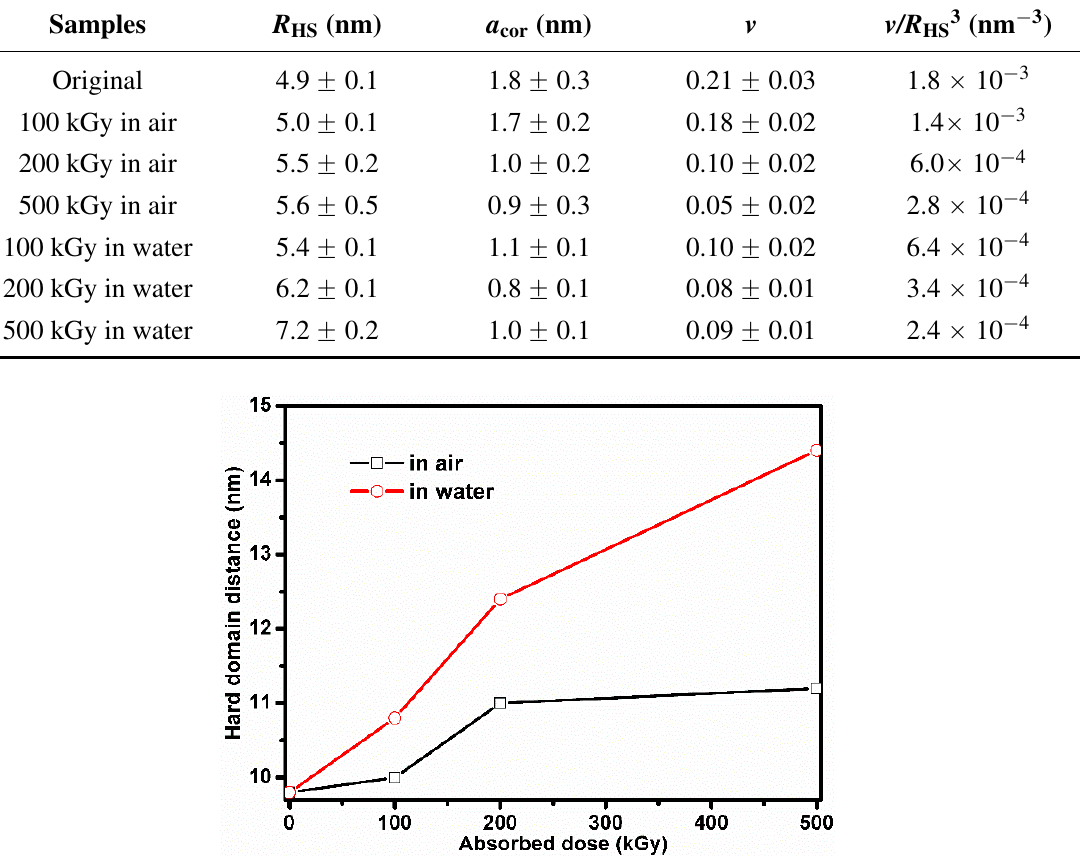
Figure 3. Variation of the hard domain distance (2 R HS ) with the absorbed dose, as obtained by SANS model